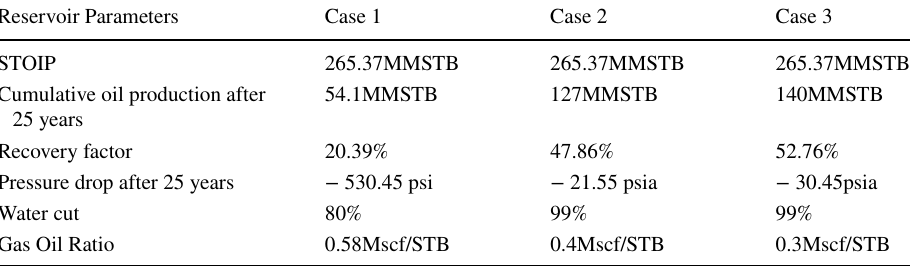
Production Prediction with Waterflooding for 25